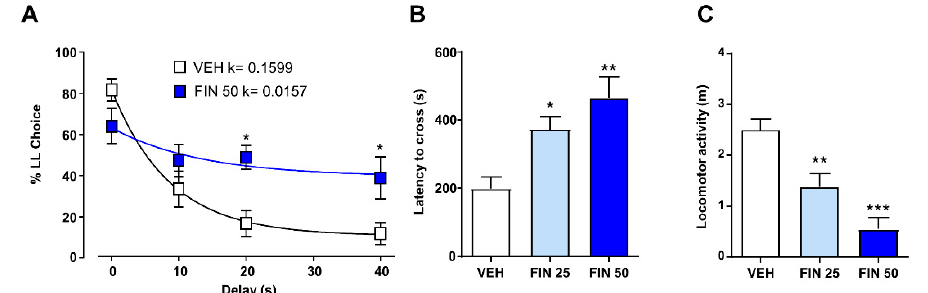
Figure 5. Finasteride (FIN) decreased impulsive and risk-taking responses. In the delay-discounting paradigm ( A ) , FIN decreased the discounting rate corresponding to longer delays (20 and 40 s); n = 11–12 / group. In the wire-beam bridge, FIN-treated rats showed longer latency to cross the bridge ( B ) and an overall reduction in the distance traveled on the apparatus ( C ); n = 10 / group (C). * p < 0.05, ** p 0.01, *** p < 0.001 in comparison with rats treated with vehicle (VEH). Doses of FIN are indicated in mg / kg